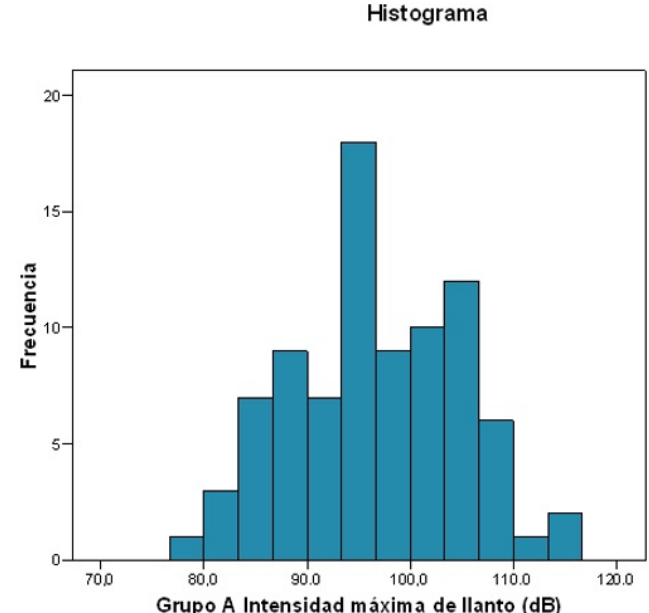
Figure 3. Frequency histogram about crying intensity.